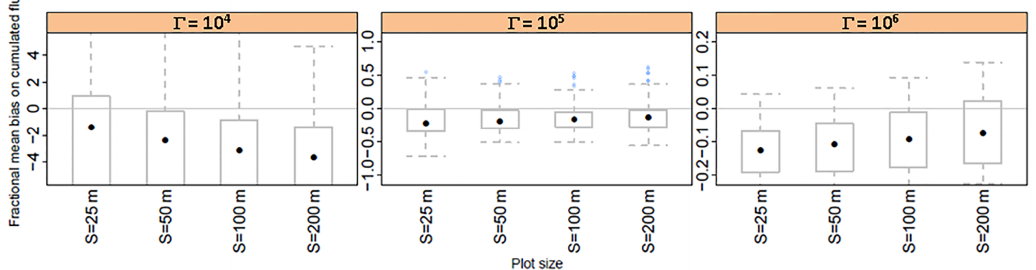
Figure 11. Effect of plot size on source inference in a multiple-plot set-up for integration periods of 168h and target heights of 0.25 and 0.5m. Same as in Fig. 8.